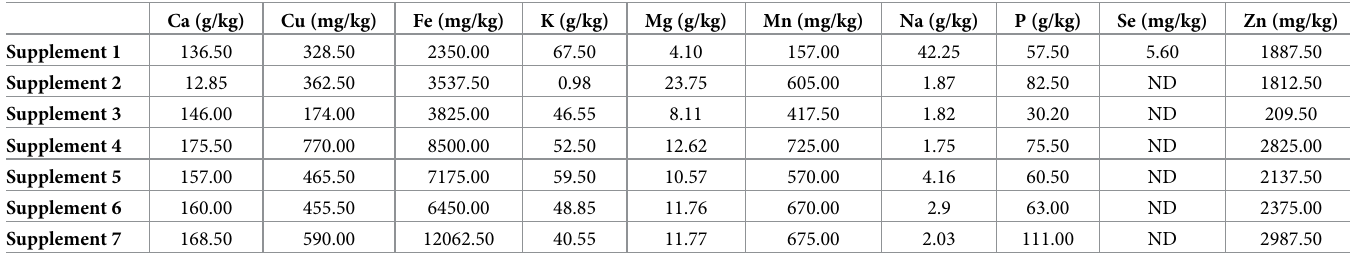
Table 1. Concentrations of minerals in original matter of the analyzed